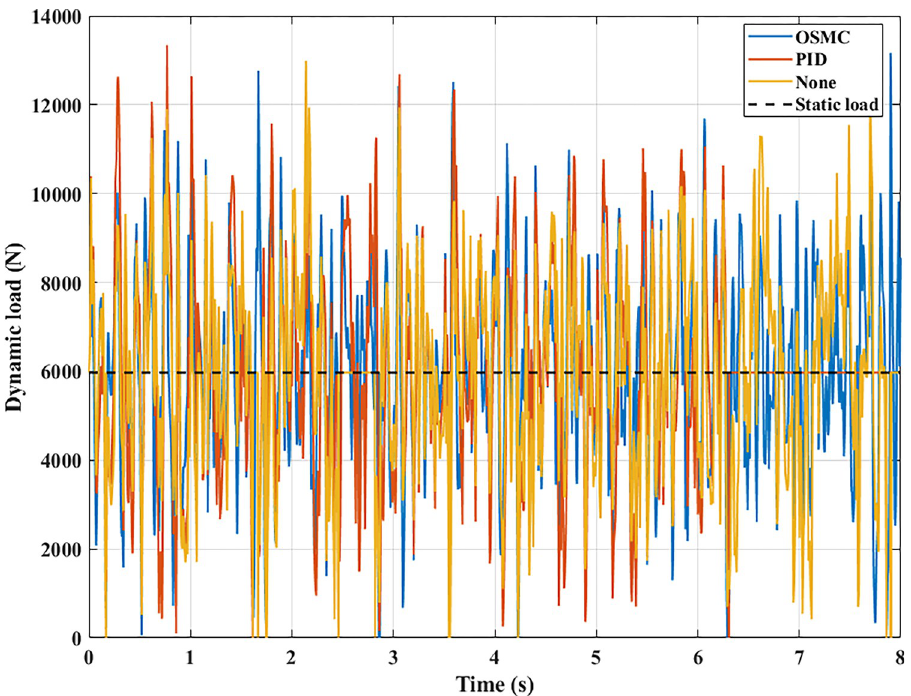
Fig 15. Dynamic load (case 3).